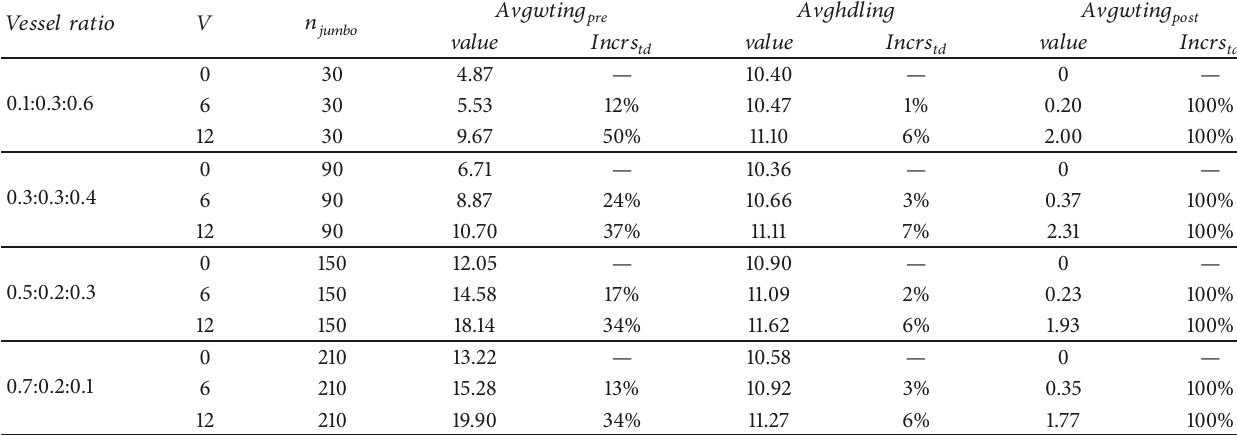
Table 6: Tidal impact on jumbos waiting